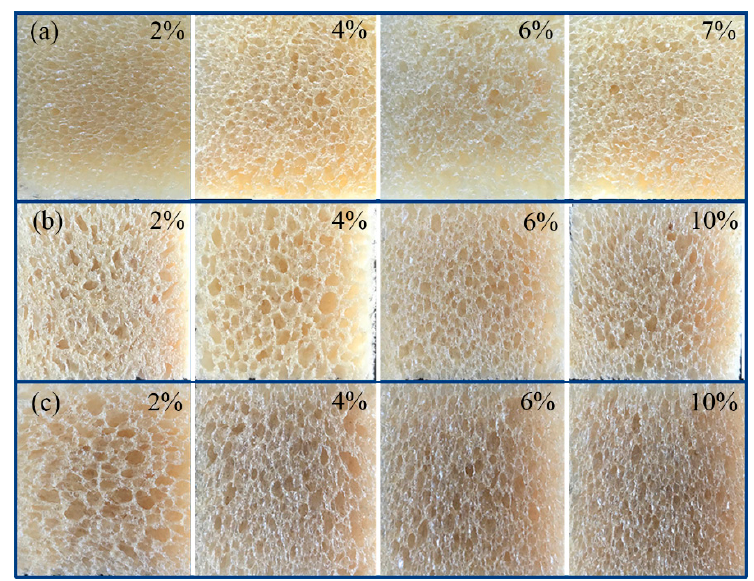
Figure 5. Camera pictures of ( a ) RPUF/SiO 2 (7 wt %), ( b ) RPUF/PS (10 wt %), and ( c ) RPUF/PB (10 wt %).